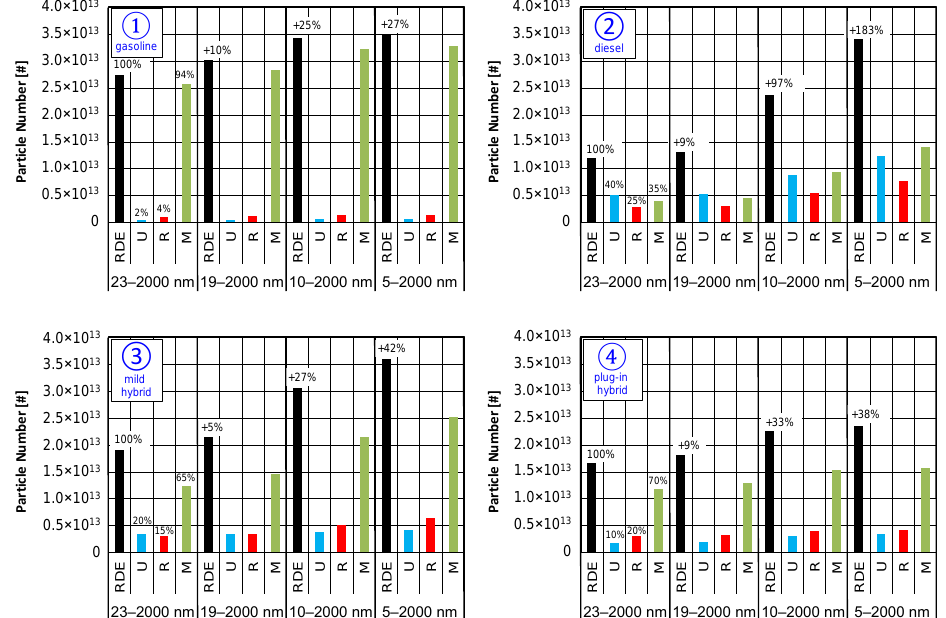
Figure 13. Total number of particles for vehicles 1 – 4 in the RDE test and its individual parts (urban, rural, motorway), along with a division of the diameters considered; 1 — gasoline, 2 — diesel, 3 — mild hybrid, 4 — plug-in hybrid.